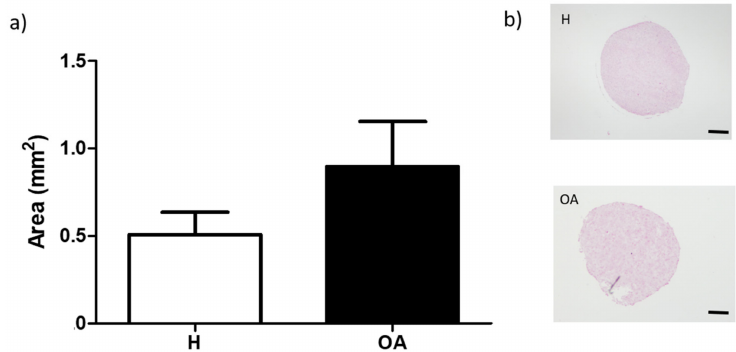
Figure 4. ( a ) Area (mm 2 ) of H- and OA-derived BM-MSCs pellets in 3D-pellet conventional system after three days, under CM. Values are given as the mean of at least three donors with standard deviation. ( b ) Hematoxylin-Eosin (H-E) staining. Scale bar: 200 µ